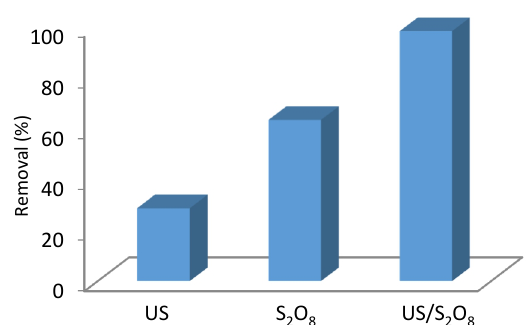
Fig. 6. Comparative removal efficiency of erythrosine B dye in the US/S 2 O 82- process, with persulfate in optimal conditions of operation, and US waves alone (pH:3; initial concentration of dye, 50 mg/L, and concentration of persulfate, 0.003